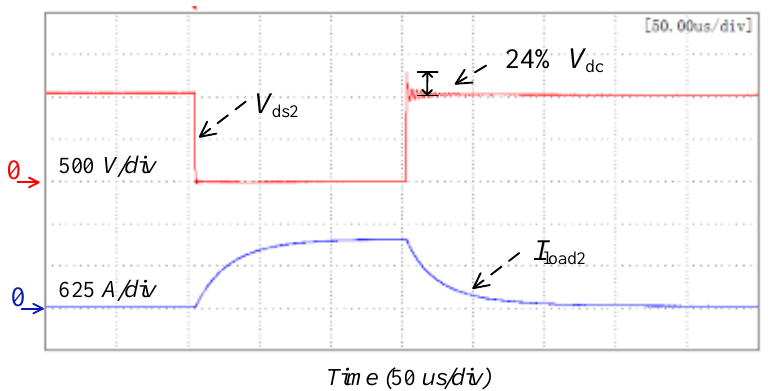
Figure 20. Switching dynamic characteristic test of LLC circuit power module.